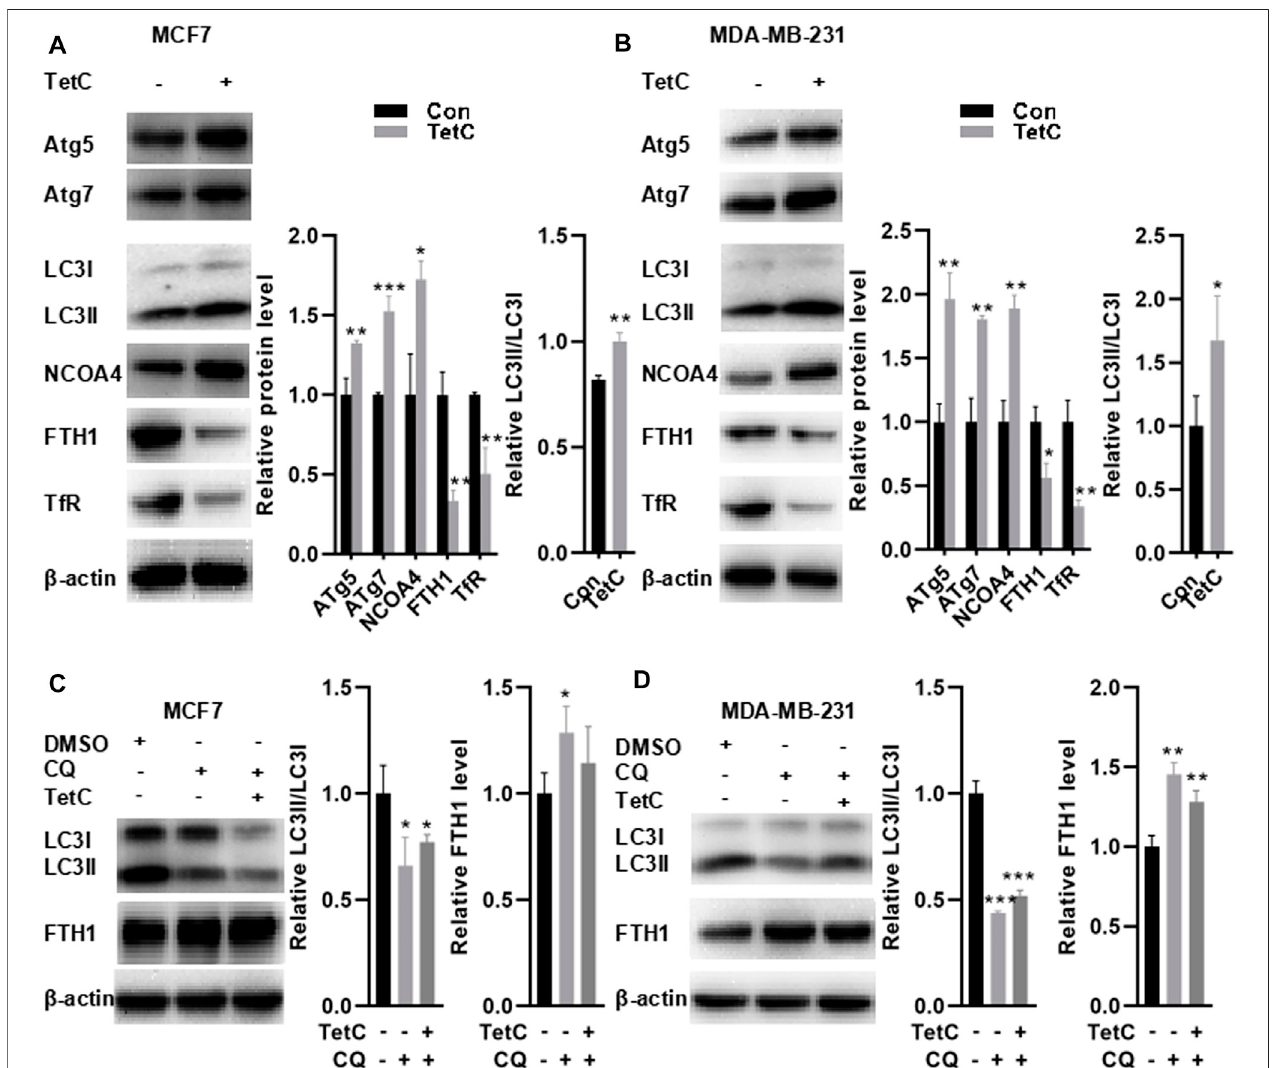
FIGURE6| FTH-1degradationisachievedbyTetC-inducedferritophagyinBCcells.MCF7andMDA-MB-231cellsweretreated20and10 μ MTetCfor24 hinthe presenceorabsenceof10 μ Mchloroquine(CQ).WesternblotassayshowedthatTetCsigni fi cantlyelevatedtheexpressionofATG5,ATG7,andNCOA4butdecreased FTH1 and TfR protein levels in MCF7 (A) and MDA-MB-231 cells (B) . TetC-induced degradation of FTH-1 expression was obviously rescued by blocking the lysosome function with CQ in MCF7 (C) and MDA-MB-231 (D) cells. * p < 0.05; ** p < 0.01; *** p < 0.001 vs DMSO.